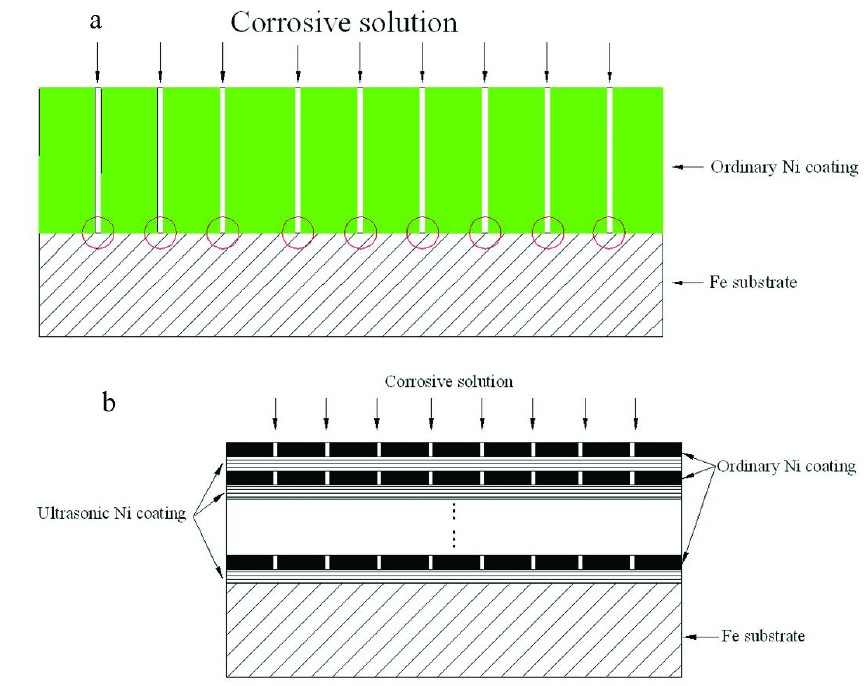
Figure 12. Schematic diagrams of corrosion mechanism of Ni coatings. (a) ordinary Ni coating (b) multilayered Ni